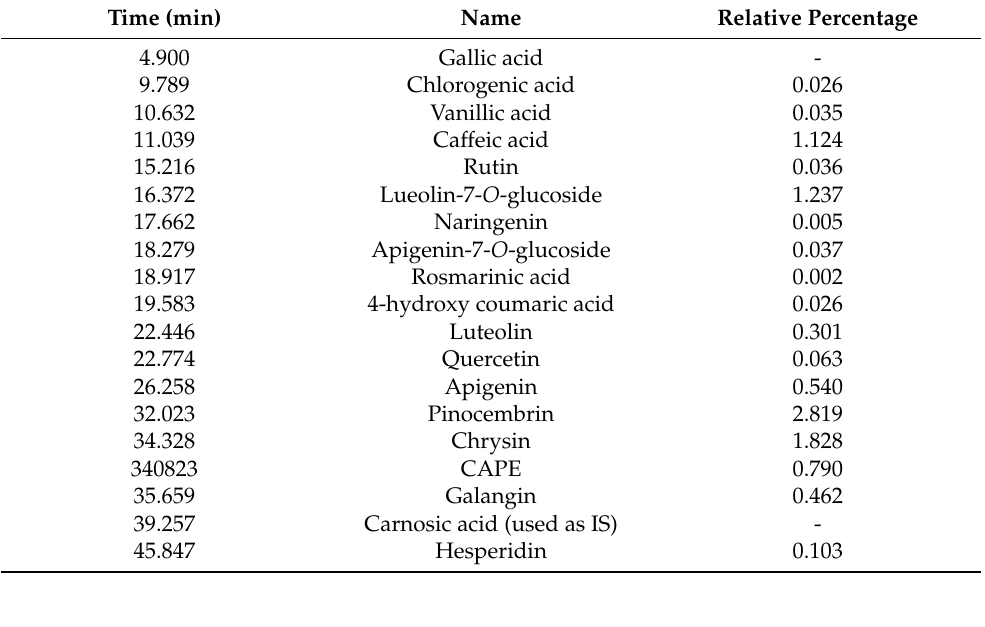
Table 2. Chemical constituents identified by HPLC-PDA in propolis sample collected from Jordan.